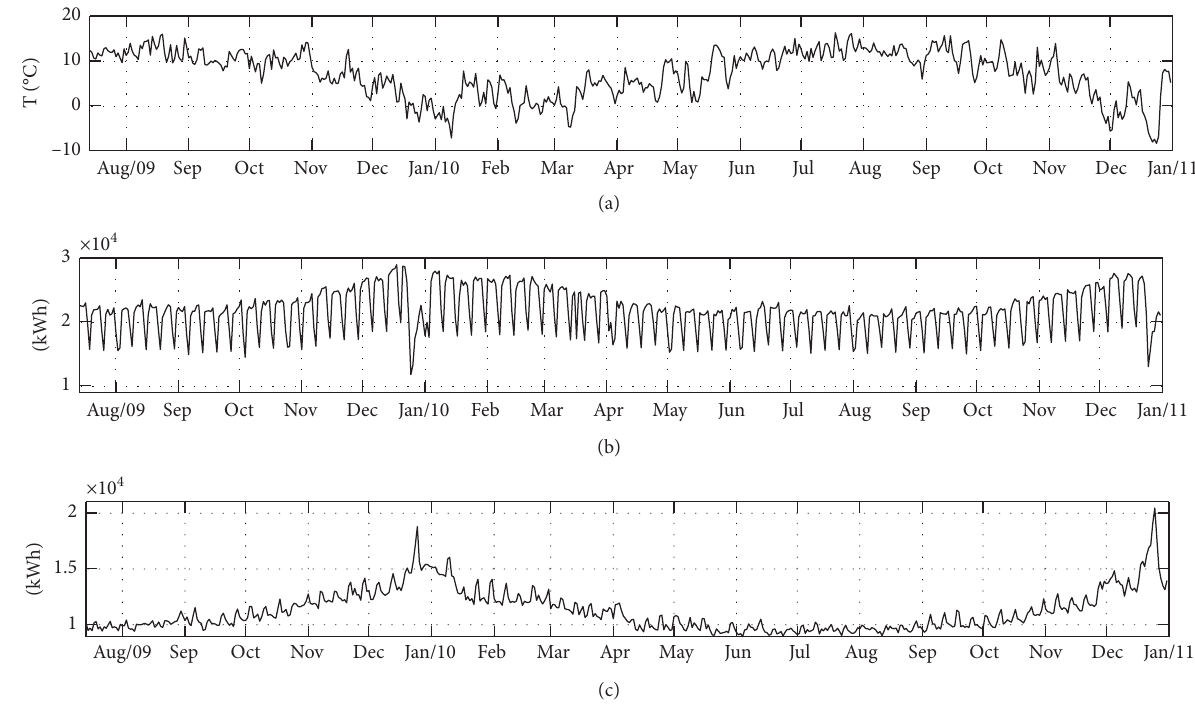
Figure 6: Residential and SME aggregate daily energy consumption compared with the average daily temperature trend. (a) Average daily temperature. (b) sme 3 daily energy consumption. (c) res 1 daily energy